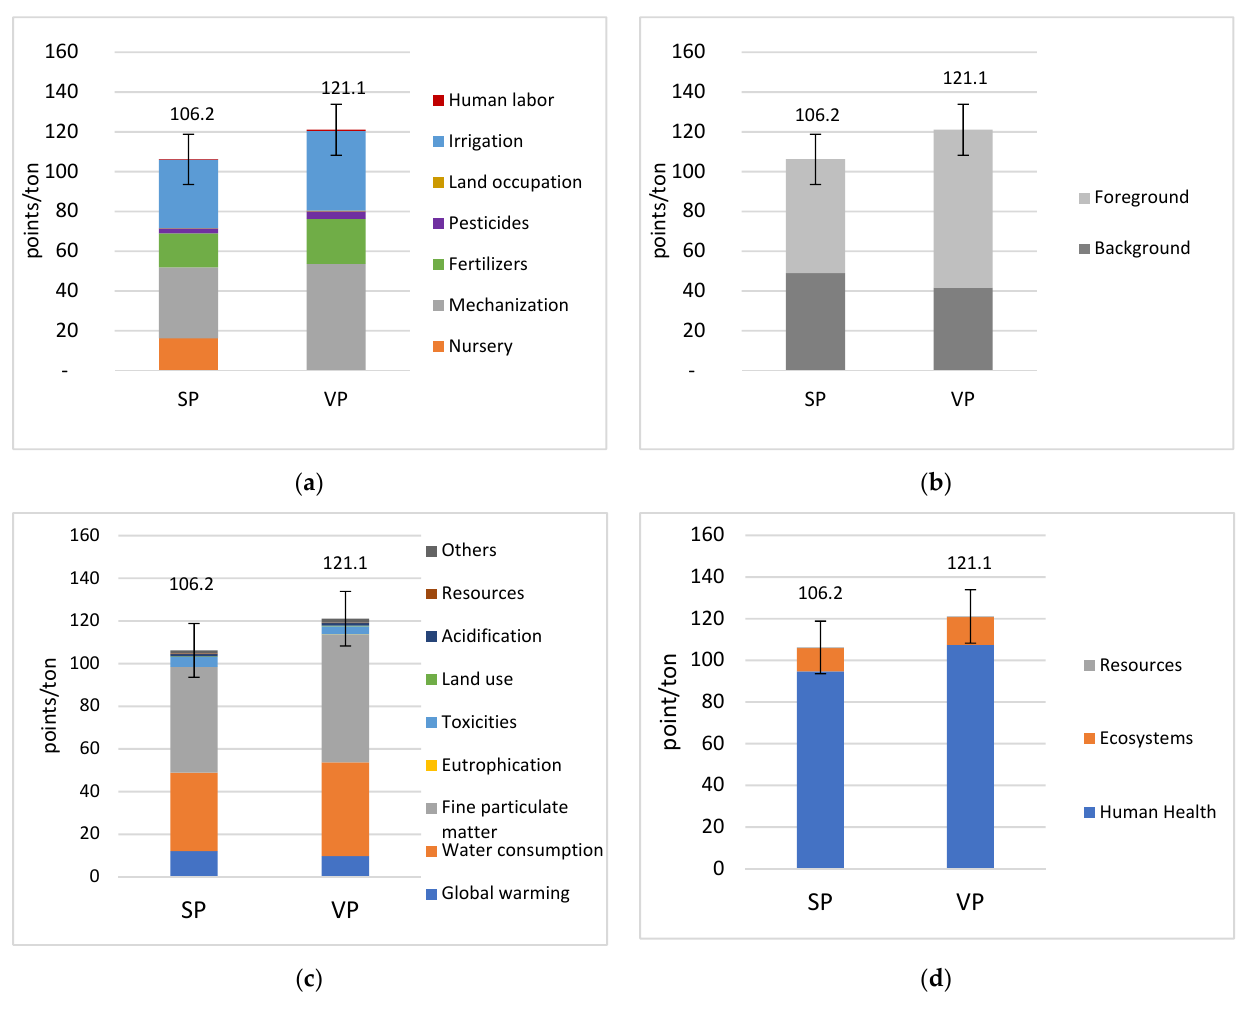
Figure 5. Cradle-to-farm gate ReCiPe single-score (in points) at different levels: ( a ) process, ( b ) subsystem, ( c ) midpoint indicator, and ( d ) endpoint indicator contribution.